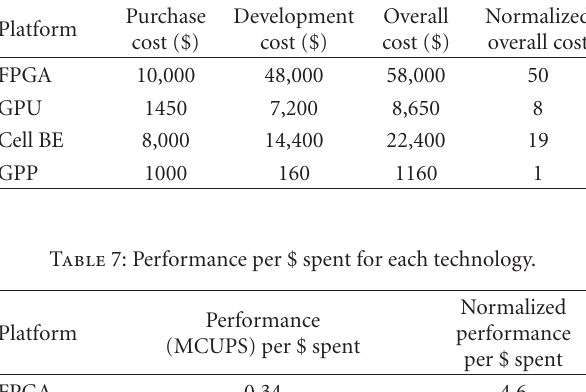
Table 4: Performance comparison for query sequence of length 256.